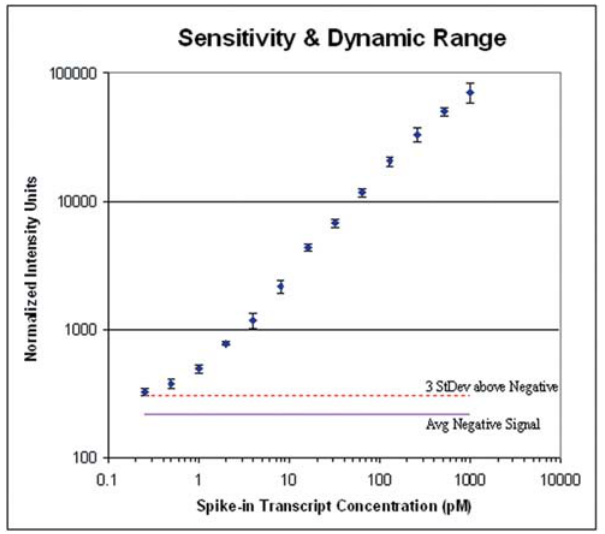
Figure 8. Hybridization analysis of 42 arrays demonstrating the sensitivity and linear dynamic range. Each point represents the mean of the normalized probe intensities for the spike-in control transcripts across three arrays plotted against the concentration of spike-in control transcripts. Error bars indicate the standard deviation across the three arrays at each data point. Spike-in control transcripts were added to a complex background of K-562 cRNA at 13 different concentrations ranging from 0.25 pM to 1024 pM (approximately 1:600,000 to 1:150 mass ratio) in two-fold increments. Sensitivity was determined to be signal detectable above the average signal for the same probes on a set of no-spike arrays (solid line) plus 3 standard deviations (dotted line).